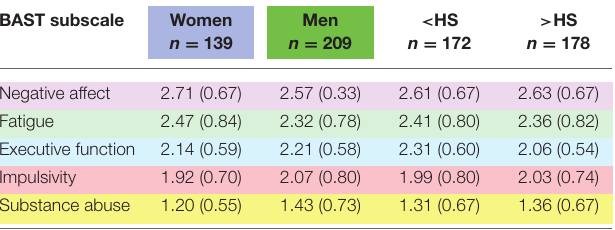
TABLE 4 | Neurobehavioral symptoms by gender and education among spanish-speakers. BAST